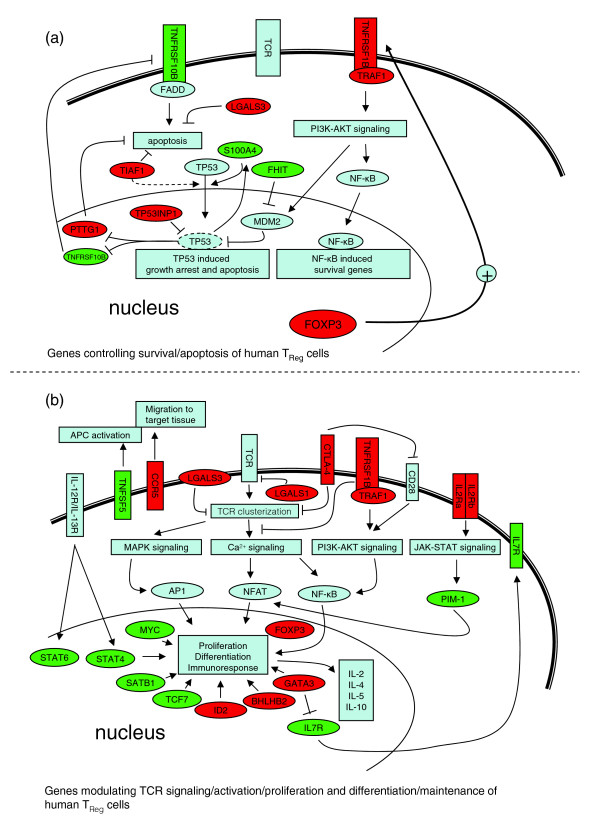
Functional dissection of signaling modules in human TReg cells. Schematic representation of potential signaling pathways involving genes that control (a) survival/apoptosis, and (b) TCR signaling/activation/proliferation and differentiation/maintenance of human regulatory T cells, thereby mediating TReg cell functionality. Transcriptional upregulation of genes in TReg versus naïve T cell is marked by red symbols, whereas green symbols represent downregulated genes. Symbols filled with grey depict unaffected genes or summarize pathway modules.